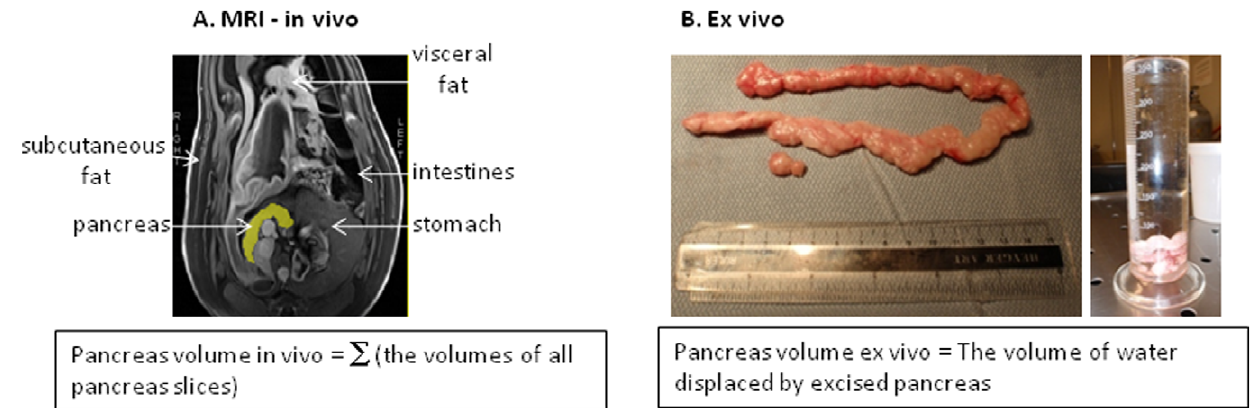
Figure 1. Pancreas volume measurements. A. In vivo – Representative abdominal image with highlighted pig pancreas. In average 20 abdominal slices were needed to cover entire mini-pig pancreas. B. Ex vivo - the extracted mini-pig pancreas.